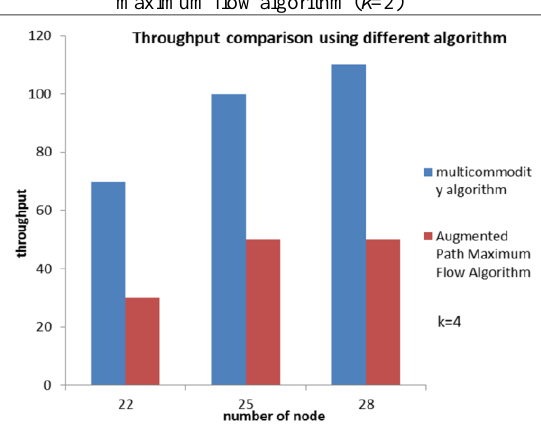
Figure 4. Results of MCFP algorithm and augmented path maximum flow algorithm ( k =2)